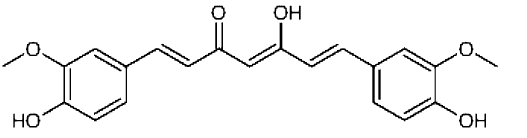
Figure 1. Chemical structure of curcumin.